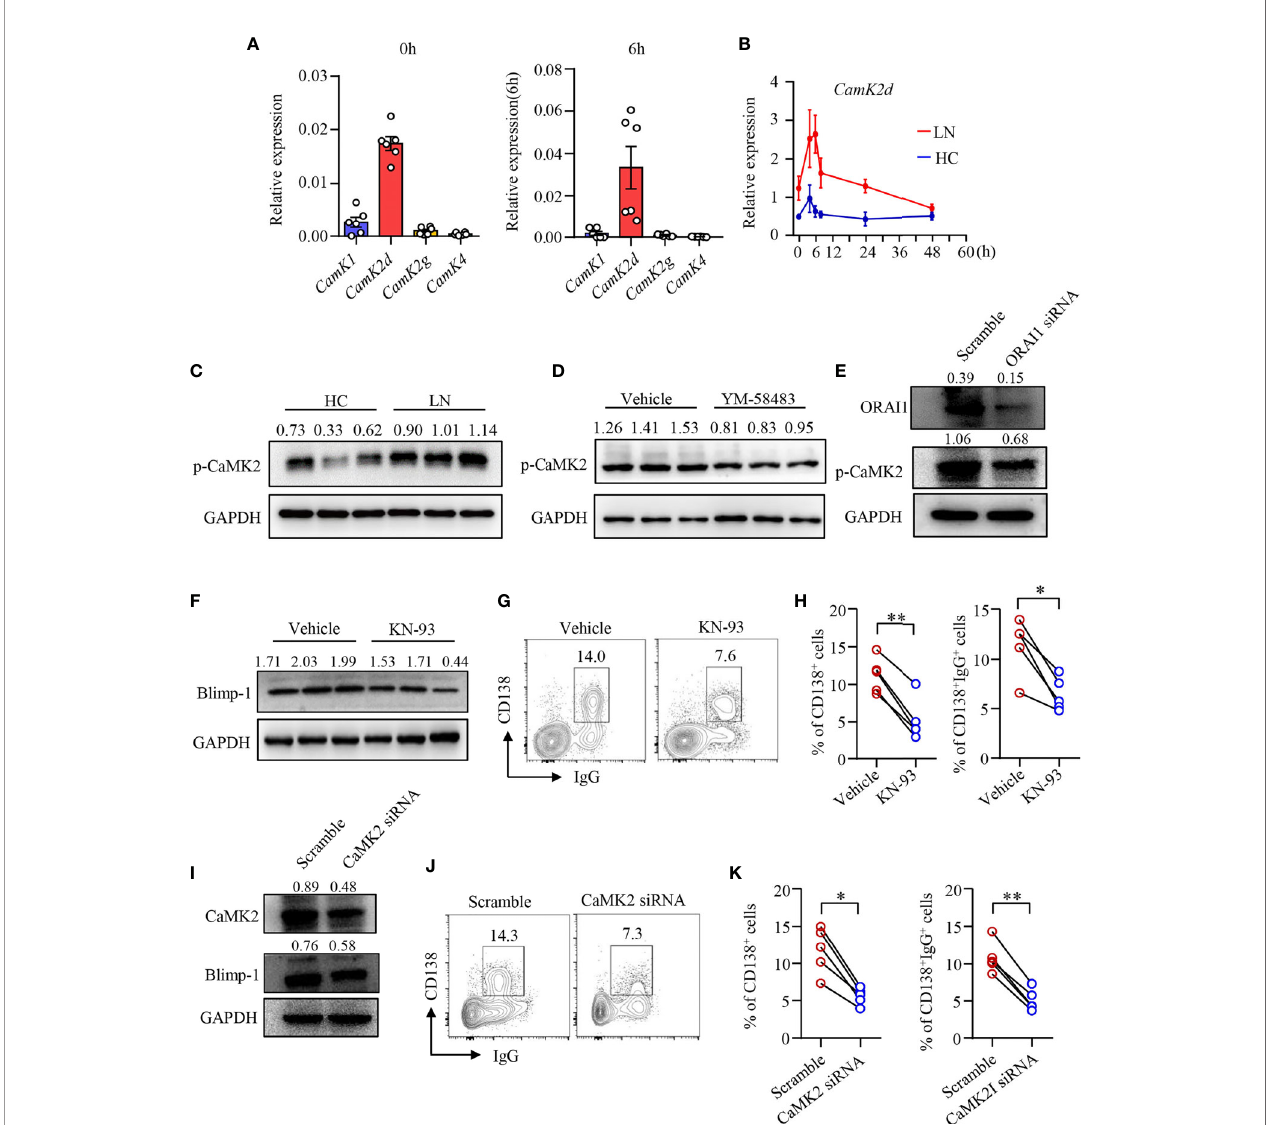
FIGURE 4 | CRAC channel suppressed B-cell differentiation by inhibiting CaMK2. (A) qPCR analysis of CaMK1 , CaMK2d , CaMK2g , and CaMK4 mRNA expression in B cells from healthy controls (HC) stimulated by anti-IgM (5 m g/ml) and anti-CD40 (1 m g/ml) at 0 and 6 h time points. (B) qPCR analysis of Camk2d mRNA expression in B cells from patients with lupus nephritis (LN) or healthy controls (HC). Data were normalized to GAPDH (n = 6). Data are mean ± SEM. (C) Phosphorylation of CaMK2 (p-CaMK2) in B cells from patients with LN or HC was measured by Western blot. Representative bands of six samples are shown. (D) p-CaMK2 in B cells treated by YM-58483 (20 nM) or vehicle was measured by Western blot. Representative bands of six samples are shown. (E) ORAI1 and p-CAMK2 expression in B cells treated with ORAI1- or scramble-siRNA was measured by Western blot. Representative bands of six samples are shown. (F) Blimp-1 expression in B cells treated with KN-93 (1 m M) or vehicle was measured by Western blot. Representative bands are shown. (G, H) CD138 and IgG expression in B cells treated with YM-58483 or vehicle. Representative counter plots are shown, and the percentages of CD138 + or CD138 + IgG + cells are summarized in dot plot with bar plot (n = 5). (I) CaMK2 and Blimp-1 expression in B cells treated with CaMK2- or scramble-siRNA was measured by Western blot. Representative bands of six samples were shown. (J, K) CD138 and IgG expression in B cells treated with CaMK2- or scramble-siRNA. Representative counter plots are shown, and the percentage of CD138 + or CD138 + IgG + cells are summarized in dot plot with bar plot (n = 5). For the Western blot data, relative expression values to GAPDH are indicated above each lane. All data are mean ± SEM. *p < 0.05, **p < 0.01 by paired